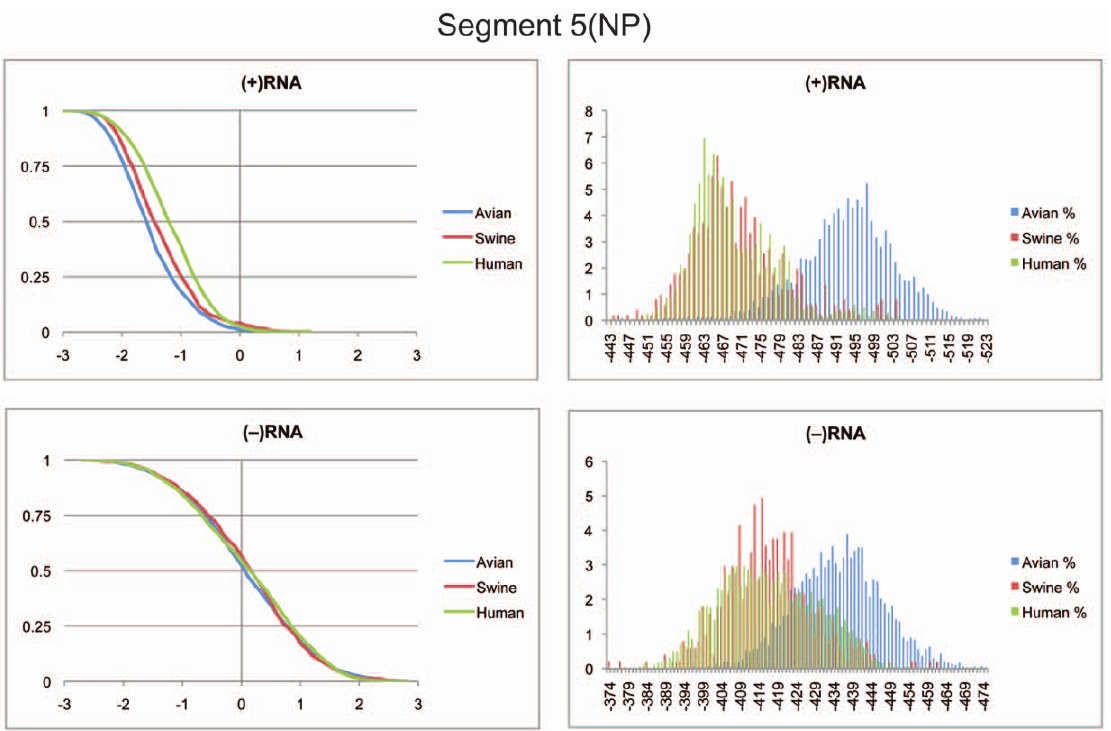
Figure 5. Cumulative and predicted free energy distributions for segment 5. Left: Cumulative distribution plots of z-scores for segment 5 in the ( + )RNA (Top) and ( 2 )RNA (Bottom). See Figure 1 for annotations and details. Right: Predicted free energy distributions at 37 u C for segment 5 in the ( + )RNA (Top) and ( 2 )RNA (Bottom). See Figure 2 for annotations and details.